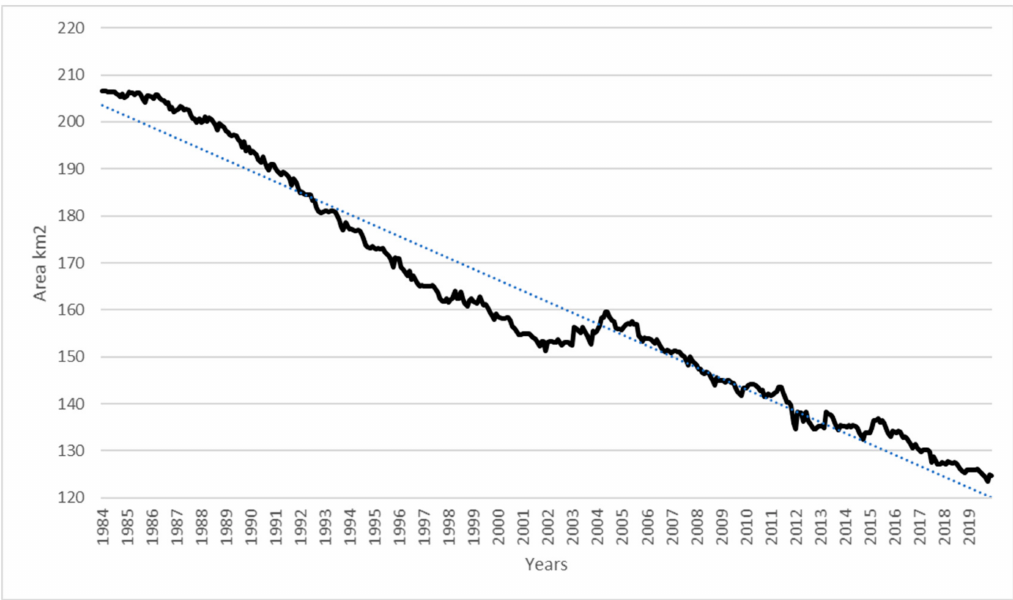
Figure 5. The trend and temporal variation in the lake area between 1984 and